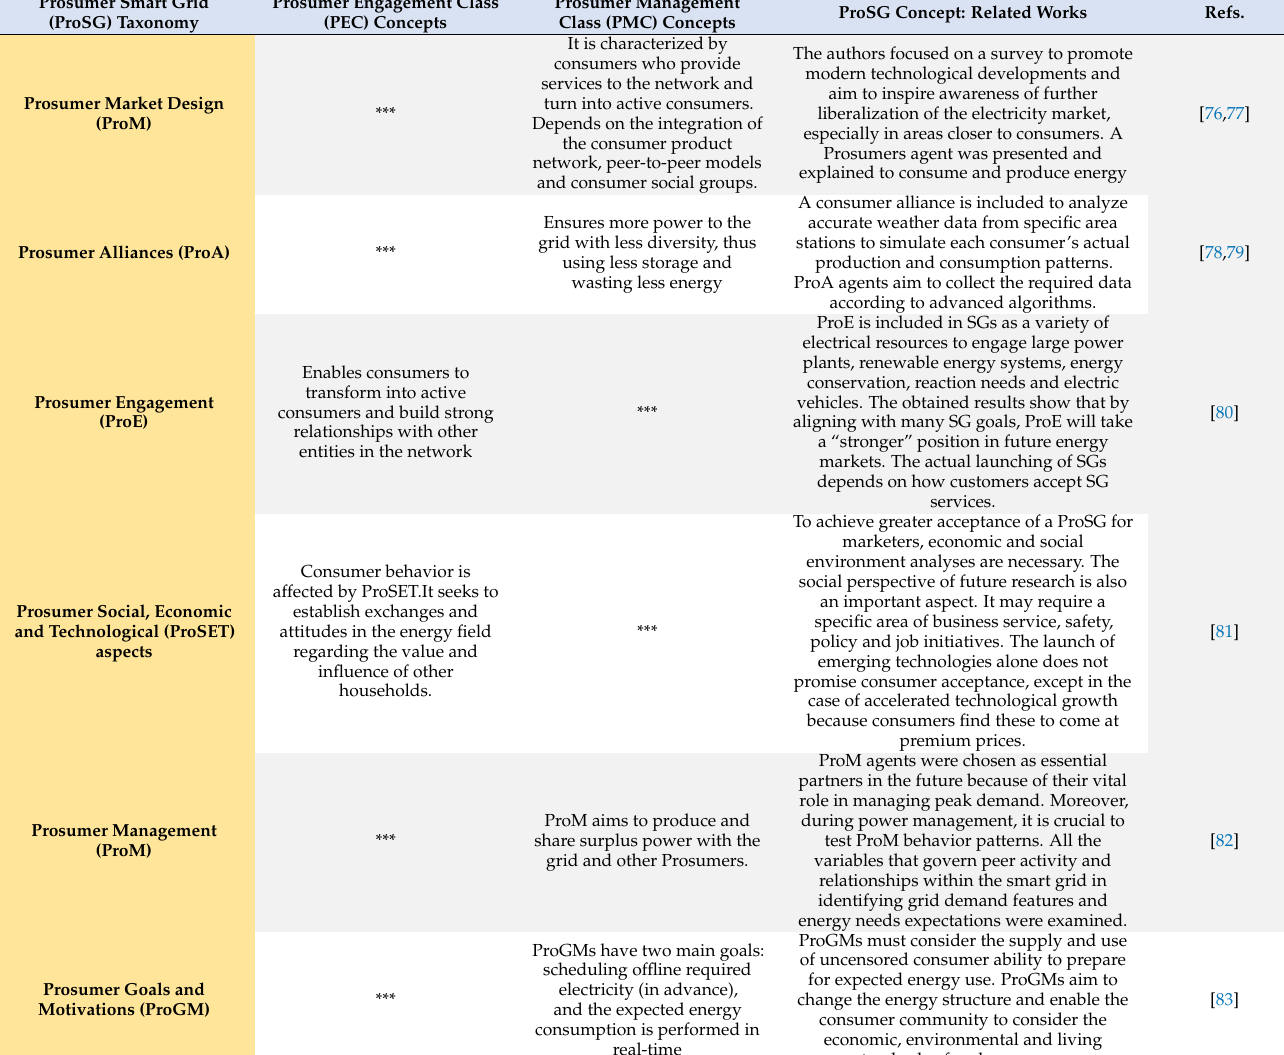
Table 2. Prosumer SG 2.0 agent